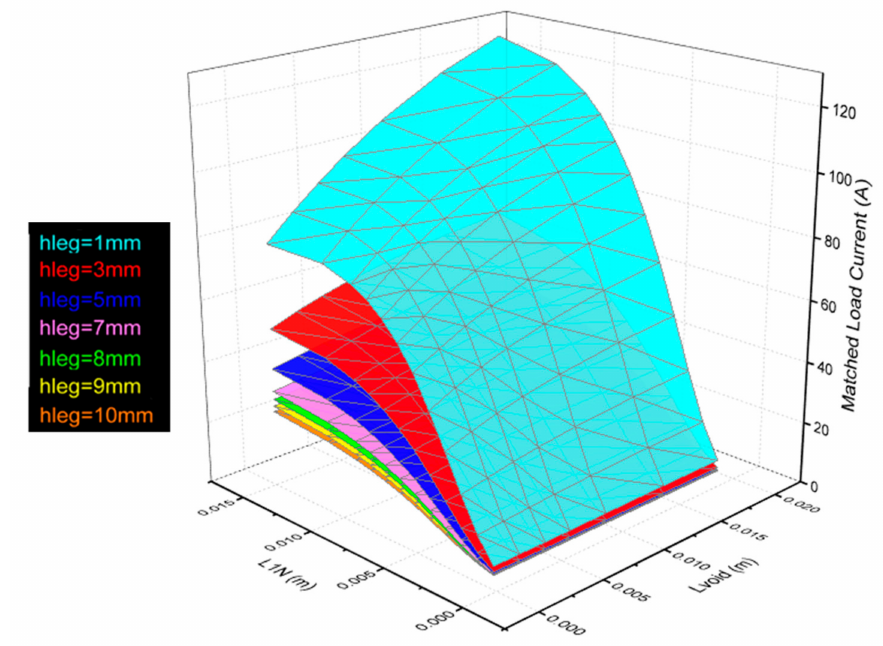
Figure 14. Matched load current as a function of n-type diameter, L 1 N , and element spacing, L void , for several element thicknesses, h leg